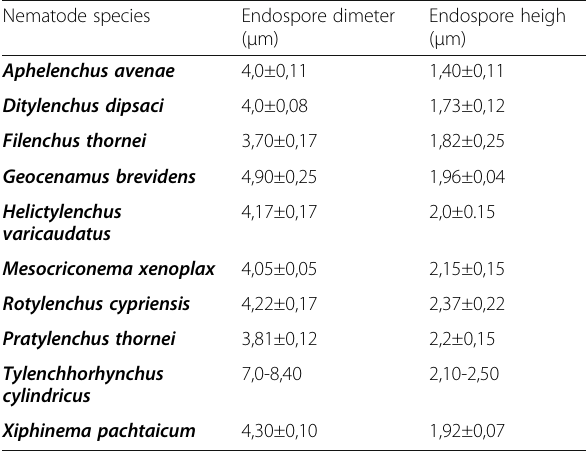
Table 3 Endospore measurements of different Pasteuria isolates Nematode